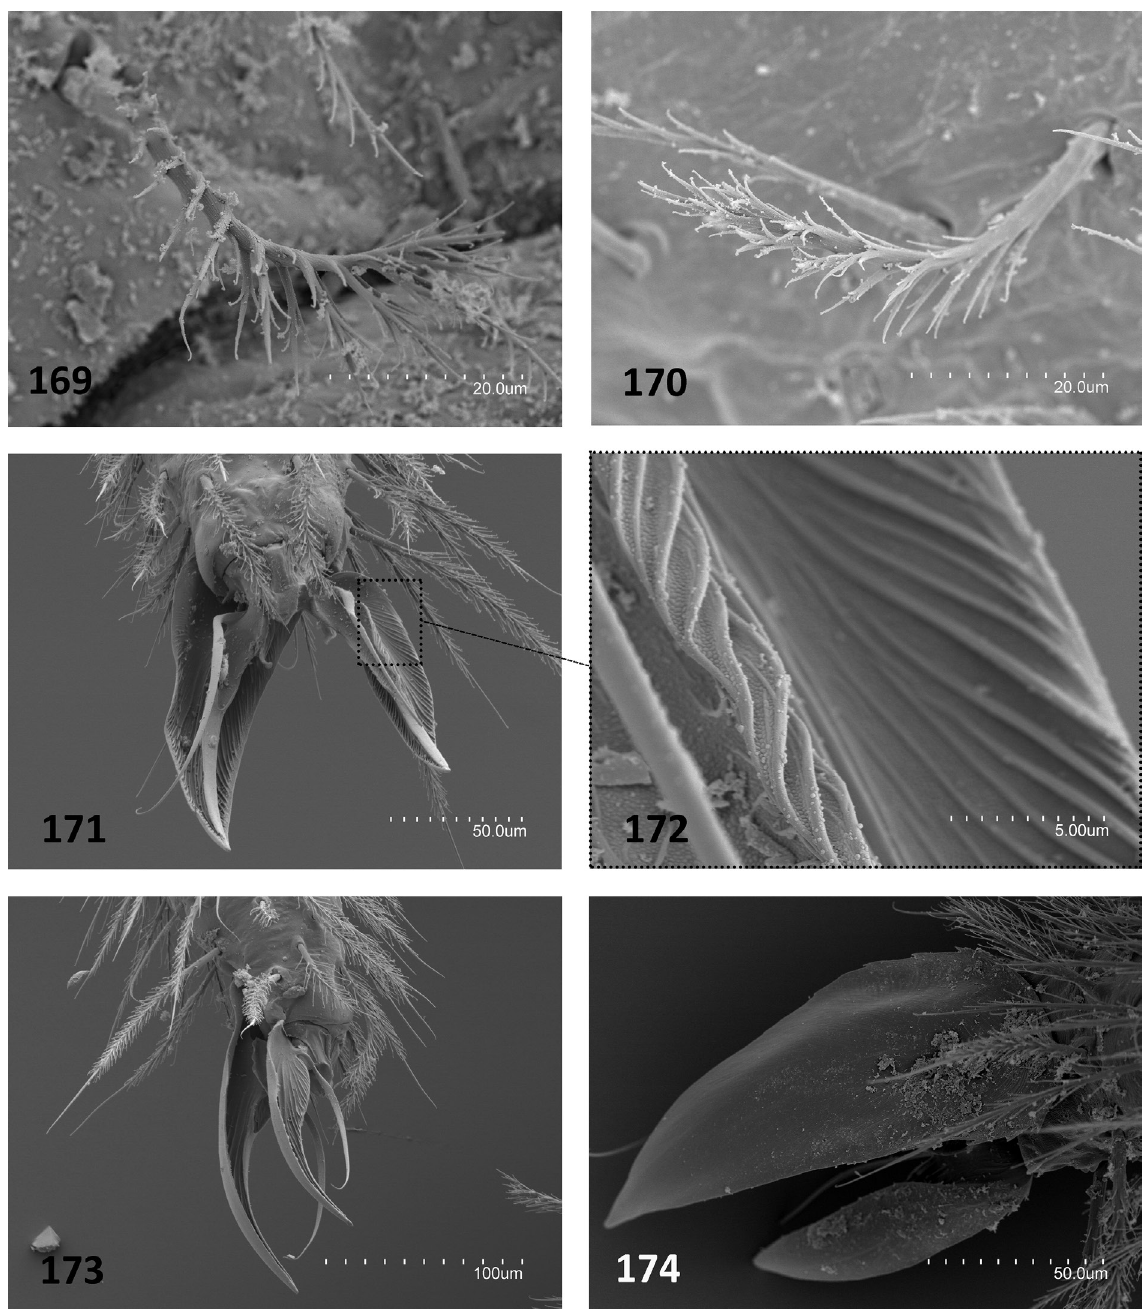
Figs 169–174. Plusiocampa ( Stygiocampa ) nivea (Joseph, 1882), from Velika ledena jama v Paradani, Predmeja, Slovenia (169, 171–174) and Jabčina (Pećina Jabčinov stržen), Račice, Podgrad, Slovenia (170) (Coll. AS). 169 . Macrosetae on urosternite I. 170 . Macrosetae on urosternite I. 171 . Pretarsus, ventral view. 172 . Ventral side of claw, detail. 173 . Lateral side of pretarsus with anterior claw in the foreground. 174 . Pretarsus, dorsal